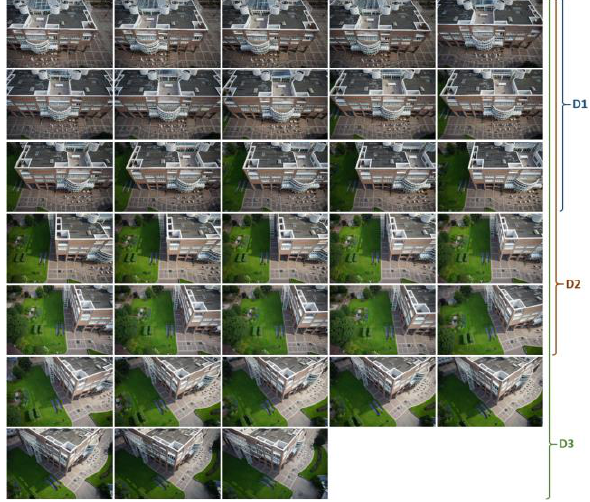
Figure 3. Images of the first (D1), second (D2) and third (D3) dataset